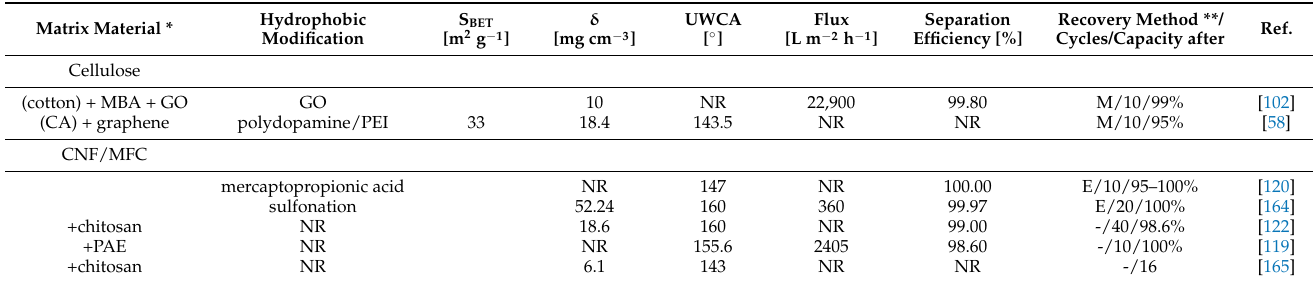
Table 3. Oleophobic aerogels used as